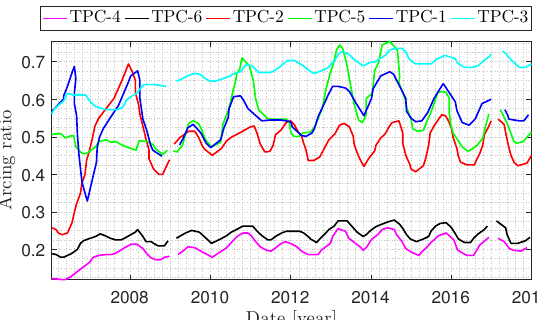
Figure 10. Variation of arcing ratio in total pressure cells in section